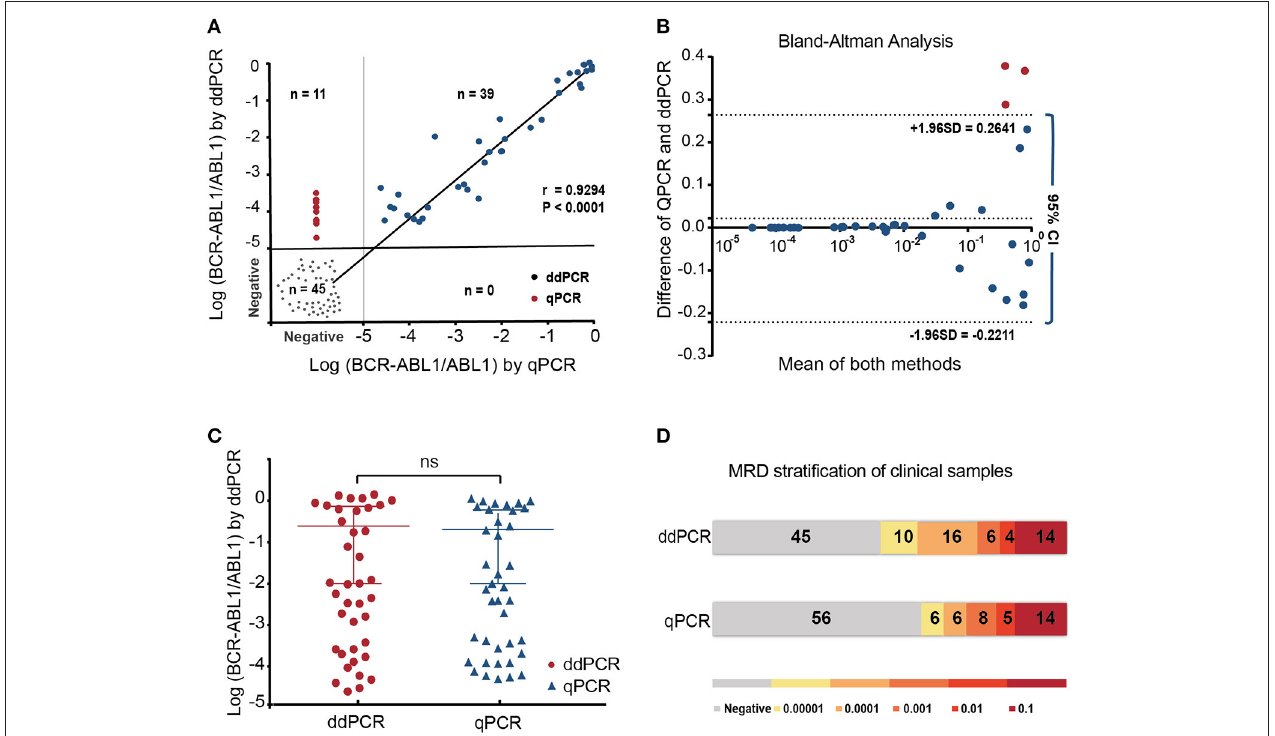
FIGURE 1 | The performance of ddPCR and qPCR in minimal residual disease (MRD) analysis of 95 follow-up samples from 10 patients with Ph + ALL post-chimeric antigen receptor T cell (CAR-T). (A) MRD results were highly correlated between the two platforms using Spearman’s test ( r = 0.9257; p < 0.0001) and showed good linearity on samples over the detection range and good linearity ( p = 0.0042); (B,C) Bland–Altman analysis and paired t -test showed the reliable correlation of two methods (D) . All positive quantitative PCR (qPCR) results were identified as positive by droplet digital PCR (ddPCRP). Among 56 samples found negative using qPCR, 11 were detected positive using ddPCR, which indicated higher sensitivity of